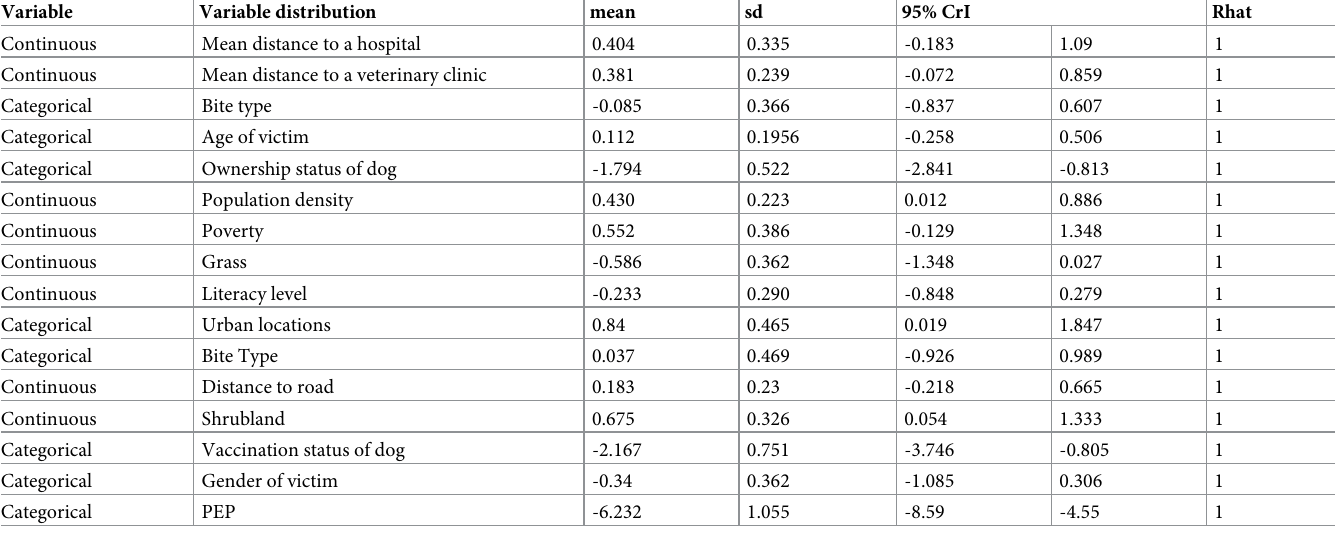
Table 2. Posterior mean, standard deviation, credible intervals, and convergence diagnostics for estimated effects on the logit (probability of deaths) due to rabies after a dog bite.